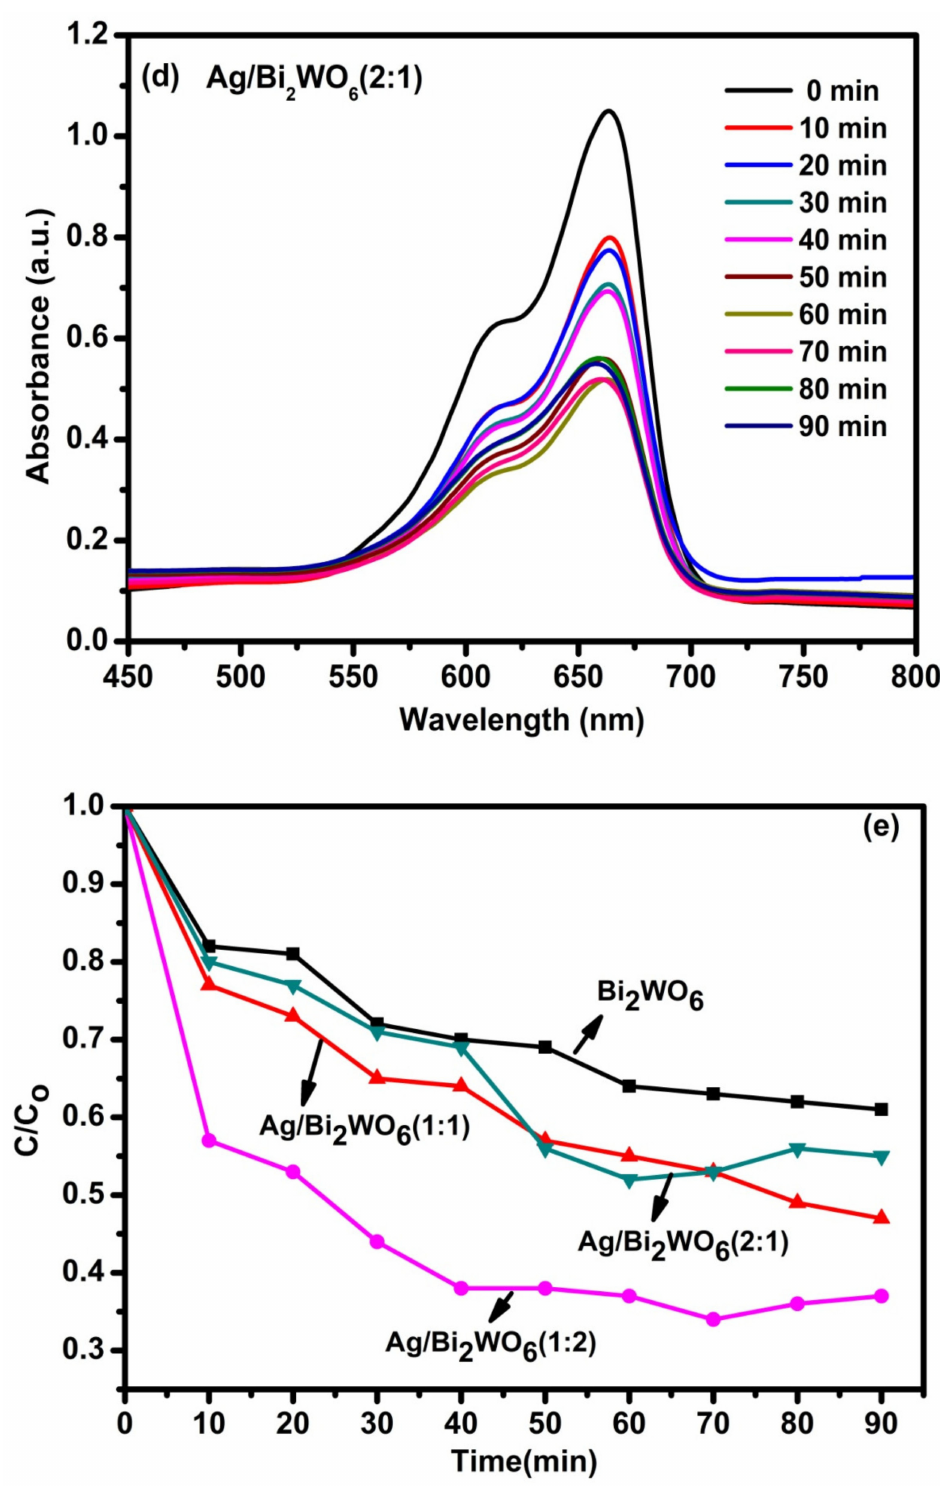
Figure 14. Photocatalytic degradation of MB by ( a ) Bi 2 WO 6 , ( b ) Ag/Bi 2 WO 6 (1:1), ( c ) Ag/Bi 2 WO 6 (1:2), ( d ) Ag/Bi 2 WO 6 (2:1) and ( e ) the photocatalytic degradation efficiency of the prepared